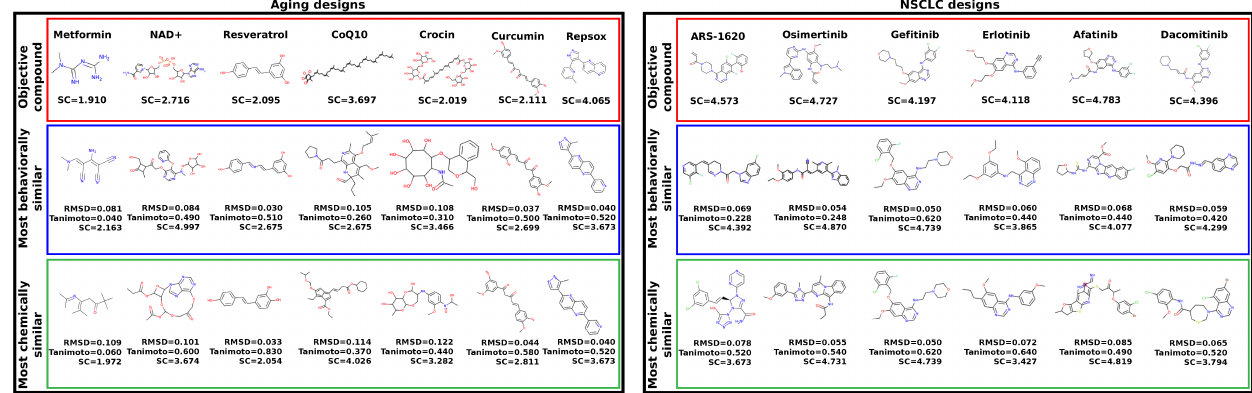
Figure 5. Analysis of the top designs generated for aging and Non-Small Cell Lung Cancer (NSCLC). The names, chemical structures, and predicted Synthetic Complexity (SC) scores of the objective compounds for aging (left) and NSCLC (right) are displayed in the top row of each panel (red border). The chemical structures of the most similar redesigns to each objective based on their interaction signatures alongside three metrics for these redesigned compounds relative to their objectives (RMSD of interaction signatures, Tanimoto coefficient, and predicted synthetic complexity) are displayed in the row below (blue border). The chemical structures of the most similar redesigns using molecular fingerprints alongside the same three metrics (RMSD, Tanimoto, and synthetic complexity) for these redesigns relative to their objectives are displayed in the bottom row (green border). The designs generated using the RCVAE pipeline retain a fair amount of structural diversity, as indicated by the fingerprint comparison scores (low Tanimoto coefficients) whilst maintaining high predicted behavioral similarity in terms of interaction signatures (low RMSDs). Other methods for evaluating our designs such as QED corroborated the above results [57]. These designs demonstrate the utility of our pipeline for designing novel compounds to combat complex indications on a proteomic scale and may be pursued further via preclinical validation